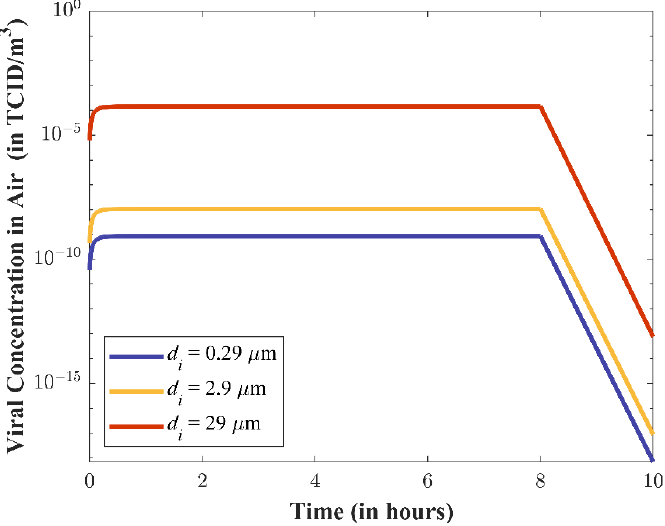
Figure 5 . Time-series predictions for the viral concentration in the air of the indoor room ( 𝐶 v 𝑖 (𝑡) ) produced by the Particle Transport submodel during coughing.